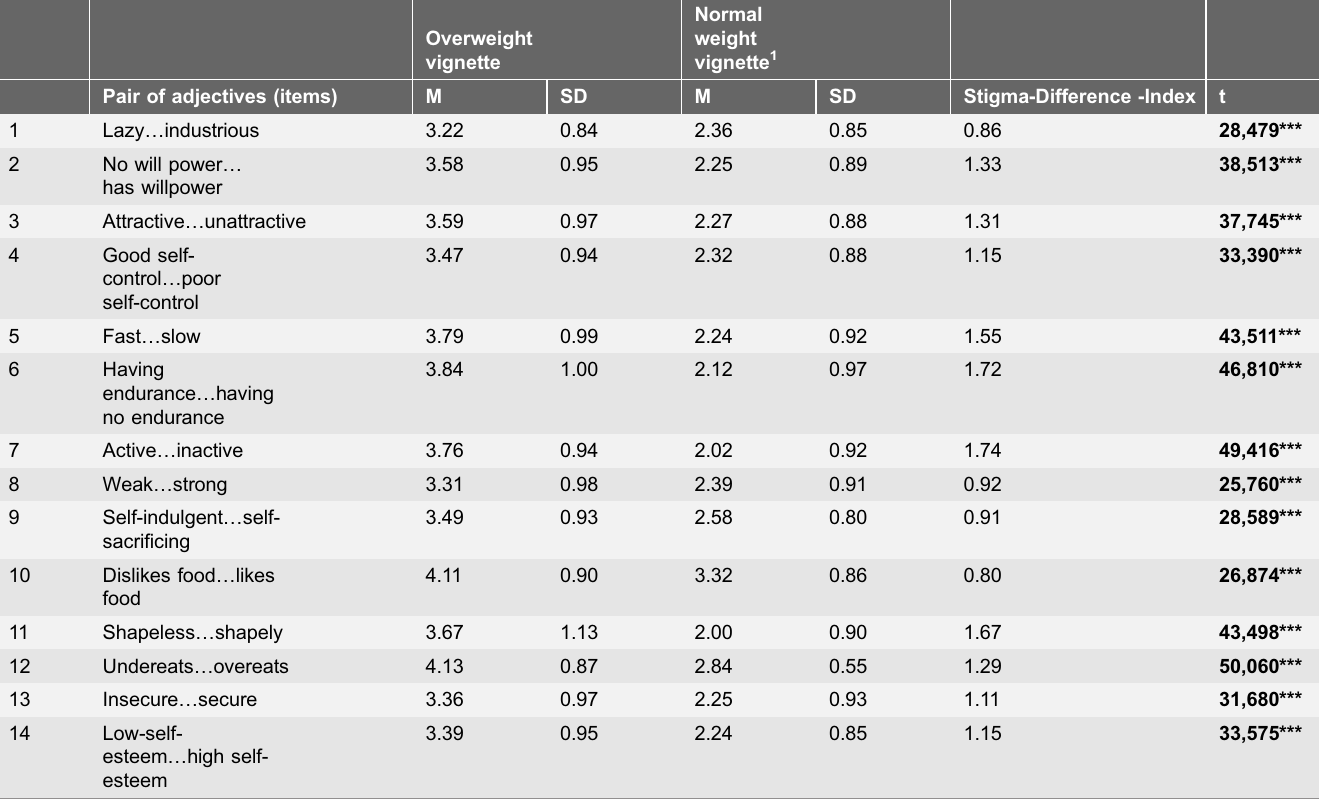
Table 3. Analyses on item level of the FPS in different conditions and results of the t-tests (n 5 1,657).